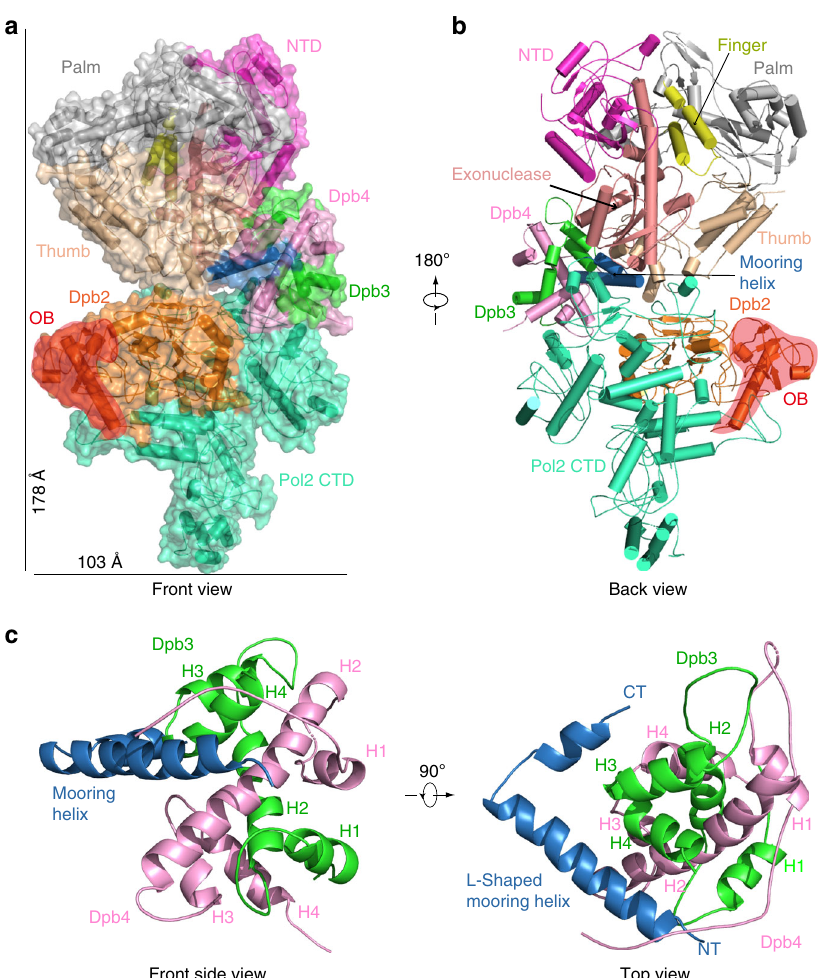
Fig. 2 Atomic model of the Pol ε . a Front view of Pol ε in cartoon and surface views. b Back view of Pol ε in cartoon view only. In a , b each subunit and each subdomain of Pol2 catalytic NTD are individually colored. The Dpb2 OB domain is shadowed red to highlight its position in front of the template DNA entrance in the middle of Pol2 NTD. c Enlarged view of the Dpb3 – Dpb4 site, highlighting the mooring helix that anchors and braces Dpb3 and Dpb4. The four helices of the histone fold in Dpb3 – 4 are labeled H1 through H4. The N-terminal and C-terminus of Dpb4 and the L-shaped mooring helix are labeled by NT and CT,